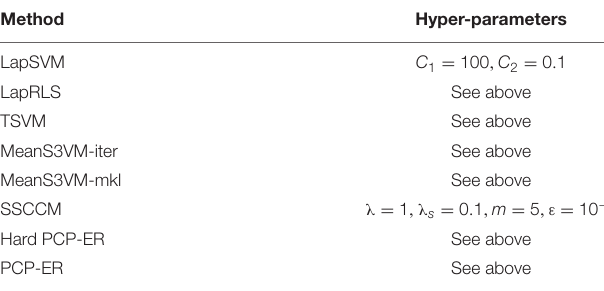
TABLE 3 | Details of hyper-parameters on DEAP dataset.